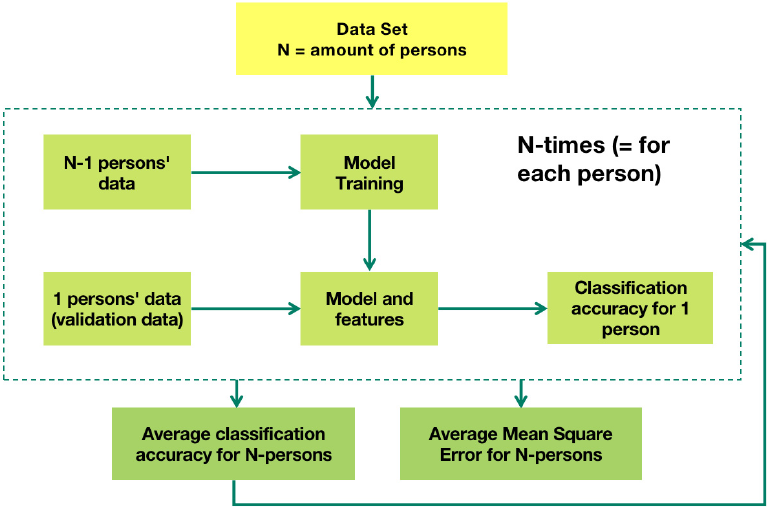
Figure A1. The principles of leave-one-person-out cross-validation.